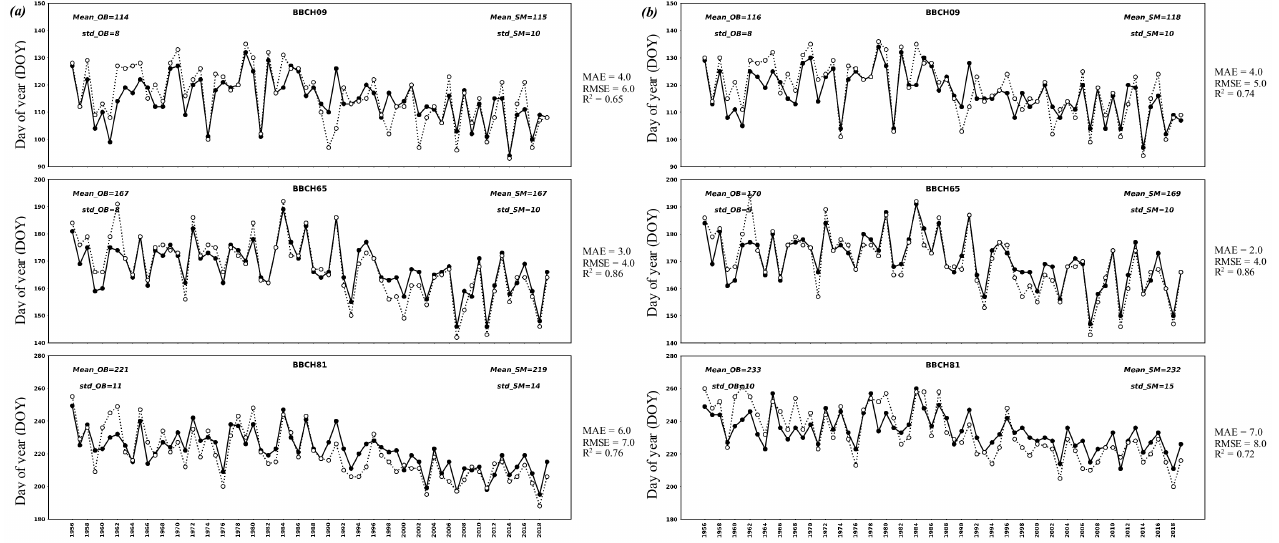
Figure 1. Comparison between time series of observed ( OB, solid line) and simulated ( SM, dashed line) DOY (day of year) for phenology stages of BBCH09 (budburst), BBCH65 (flowering) and BBCH81 (veraison) for grape varieties of ( a ) Müller-Thurgau and ( b ) Riesling over 1956–2019 at Eltviller Sonnenberg. The mean (Mean_) and standard deviation (std_) of the time series for observation and simulation are labelled. MAE (days): mean absolute error; RMSE (days): root mean squared error; R 2 : R